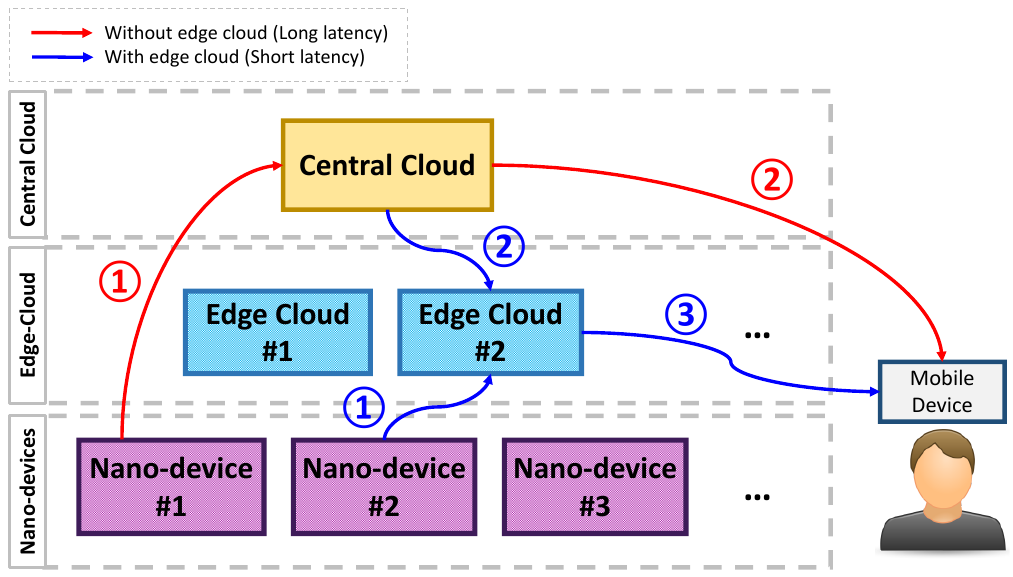
Figure 1. An example of mobile services using Internet of Nanothings (IoNT) with and without the edge cloud layer.